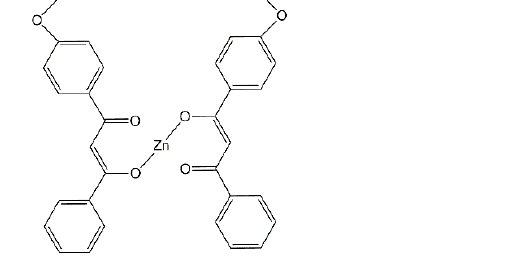
Figure 1. Structure of zinc 1-( 4′ -methoxyphenyl)-3-phenylpropane-1,3-dione (MBPP-Zn).